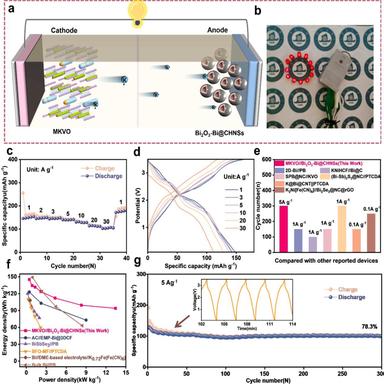
a) Schematic illustration of the MKVO//Bi2O3-Bi@CHNSs full cell. b) 12 LEDs lighted by one MKVO//Bi2O3-Bi@CHNSs full cell charged to 3.5 V. c) Rate performance and d) corresponding GCD curves of MKVO//Bi2O3-Bi@CHNSs full cell. e-f) Cycling performance and Ragone plots compared with other reported devices. g) Long-term cycling performance at 5 A g− 1 .